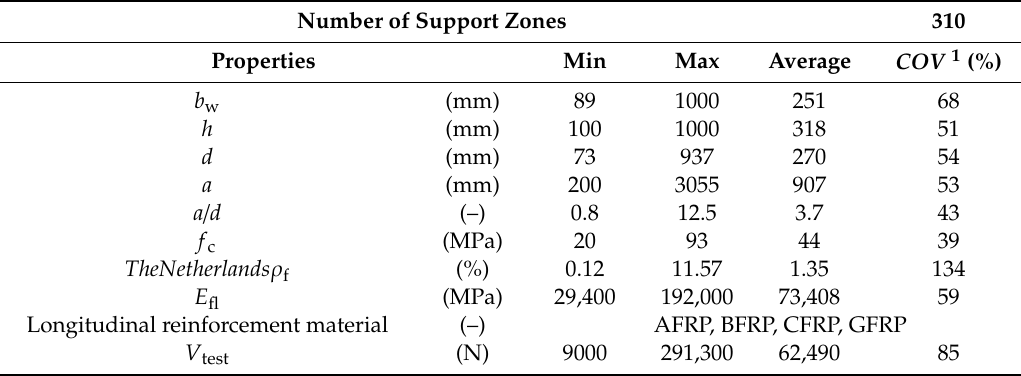
Table 2. Shear design parameters for beams used in the